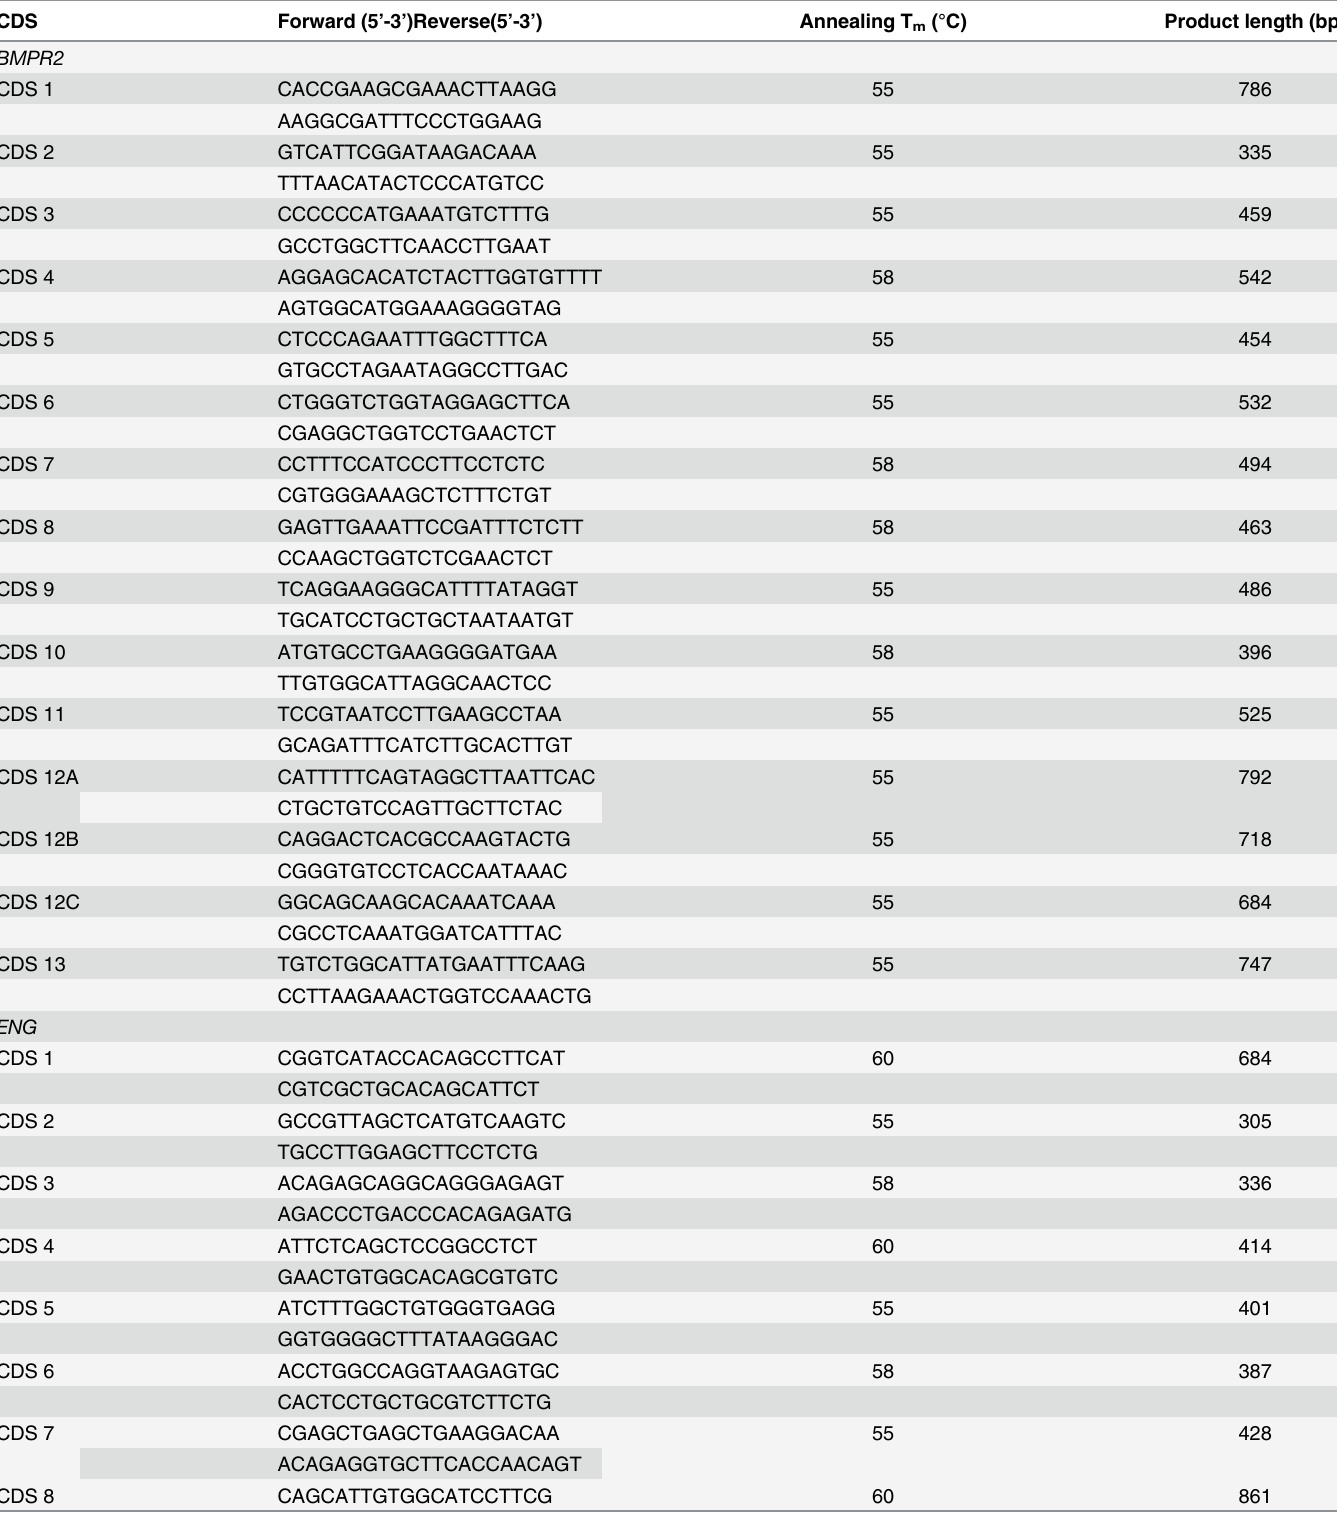
Table 1. The primer sequences used for PCR amplification of coding sequences of 7 pulmonary arterial hypertension-associated